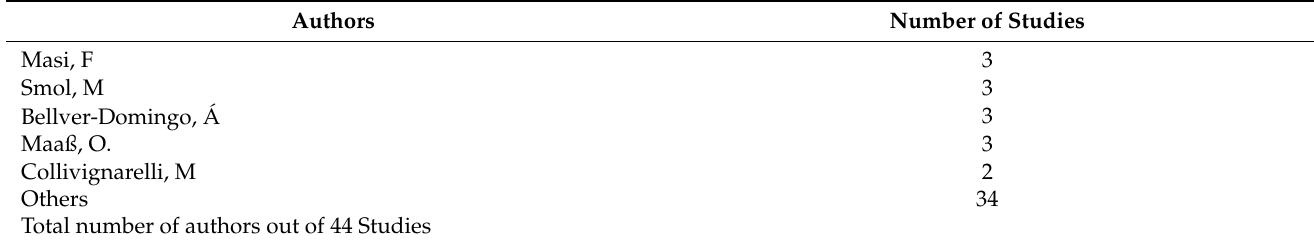
Table 2. Leading authors in terms of number of publications.